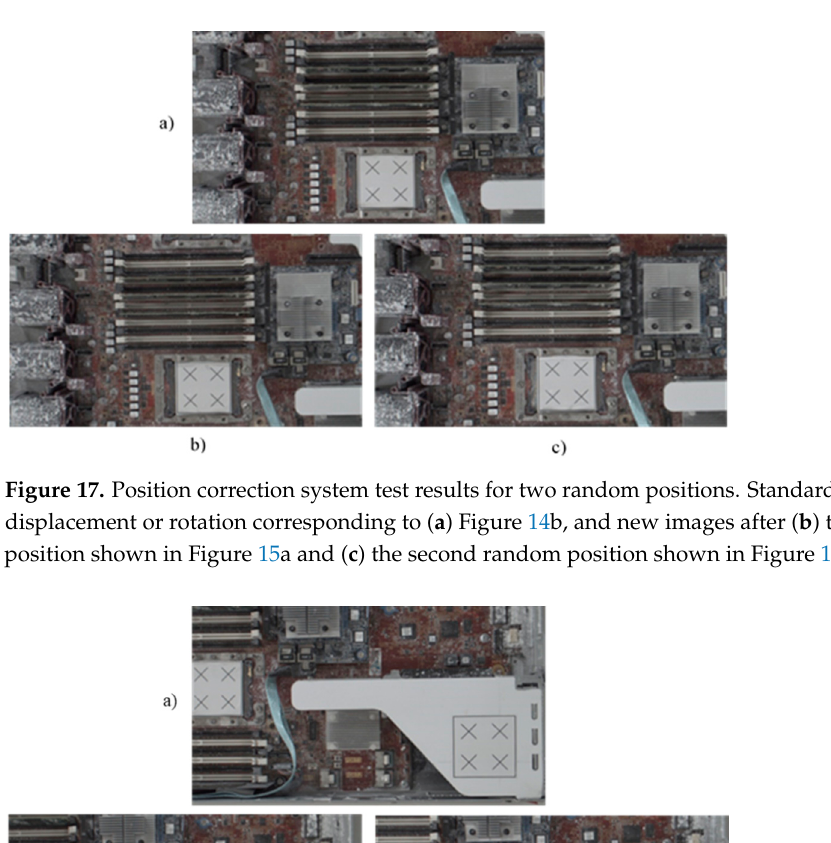
Figure 16. Position correction system test results for two random positions. Standard image without displacement or rotation corresponding to ( a ) Figure 14a, and new images after ( b ) the first random position shown in Figure 15a and ( c ) the second random position shown in Figure 15b.